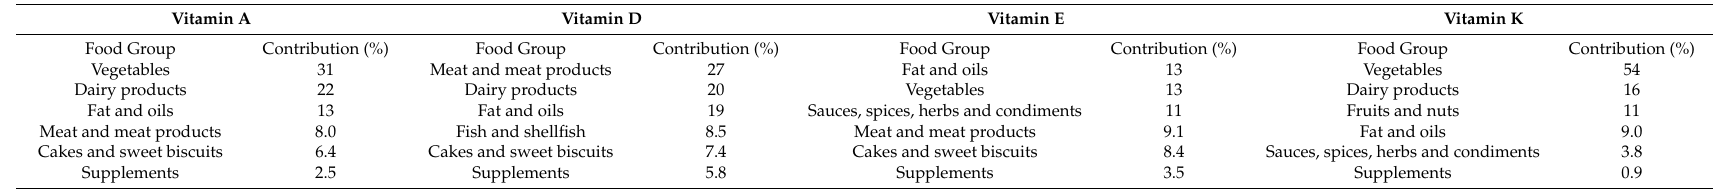
Table 2. Overview of the 5 most contributing food groups and the contribution of supplements to total vitamin A, D, E and K intake in the Belgian population 2014, Belgian food consumption survey